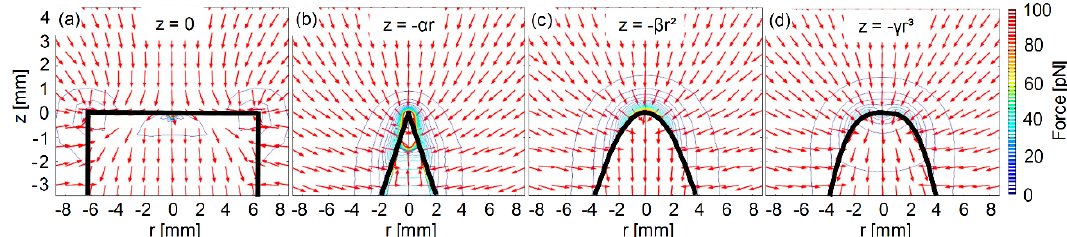
Figure 2. COMSOL Multiphysics® simulations of the magnetic force profiles of different pole tip shapes. The magnetic force profiles of four pole tip shapes; (a) flat-top, (b) conical, (c) parabolic, and (d) cubic. The color map of the contour lines represents the magnitude of the force, and the arrows represent the direction of the force.